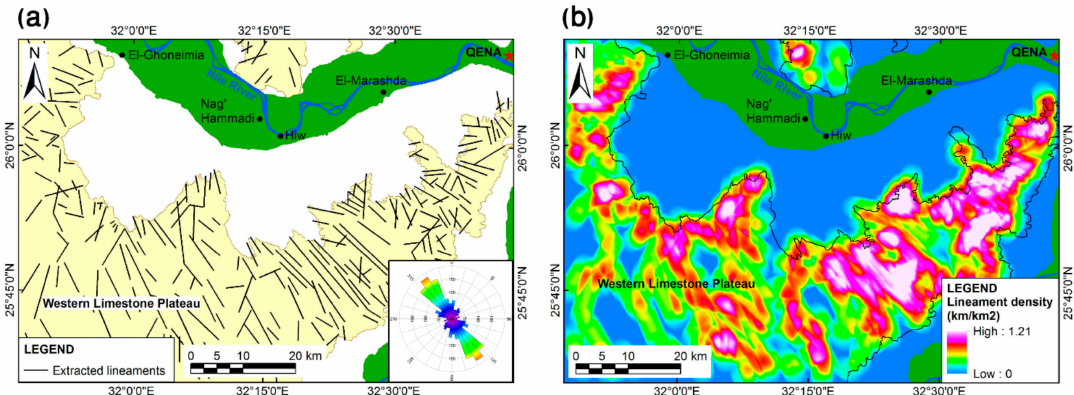
Figure 5. ( a ) Extracted surface lineaments from remote sensing data; ( b ) lineament density. The solid green color surrounding the River Nile represents the vegetation cover.